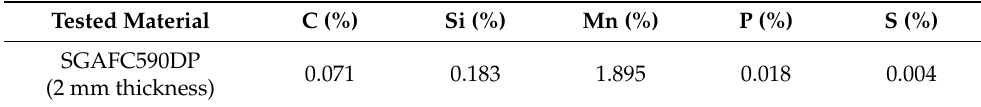
Table 1. Chemical composition (weight %) of the tested material.